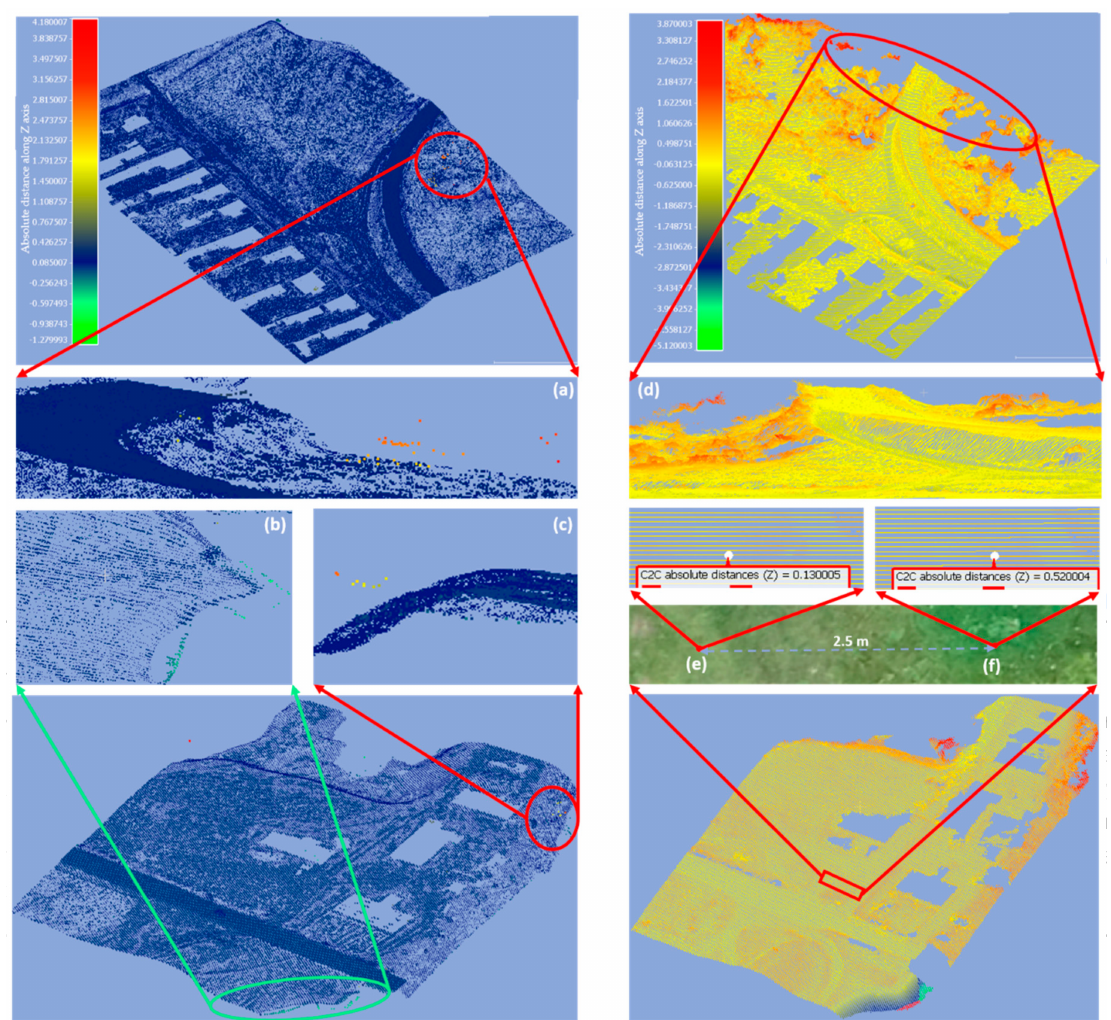
Figure 4. Visual comparison of cloud-to-cloud (C2C) absolute distance along the Z axis. Left column represents the distance between LiDAR and true data (( a , c ) represents maximum positive di ff erence, ( b ) maximum negative distance), while the right column represents distance between UAV and true data (( d ) maximum positive distance, ( e , f ) illustrate relationship between spatial variability of distance and land cover class i.e., grass and shrubs